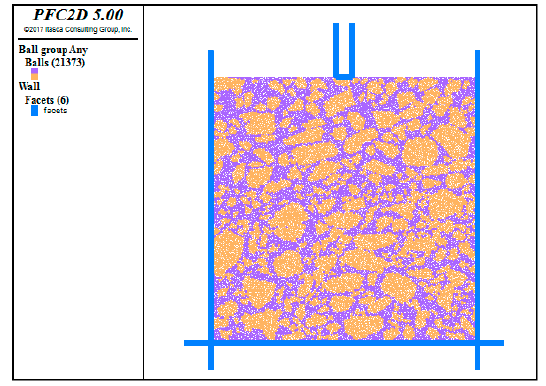
Figure 12. Uniaxial penetration model.